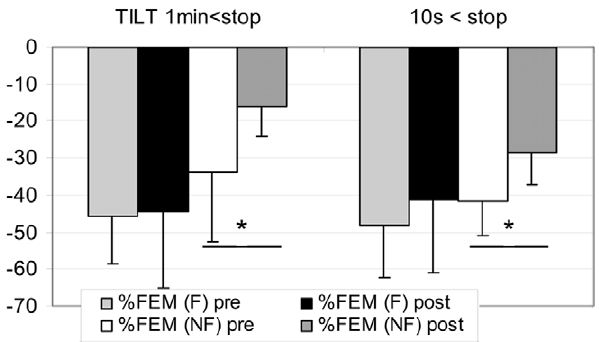
Figure 4. Percent decrease in MCA (Cerebral) flow at 1 min and 10 s before end of Tilt in F (finisher n=17) and NF (non finishers n=4). Similar change pre/post HDBR at 1 min and 10 s. (mean + / 2 SD, * P , 0.05).